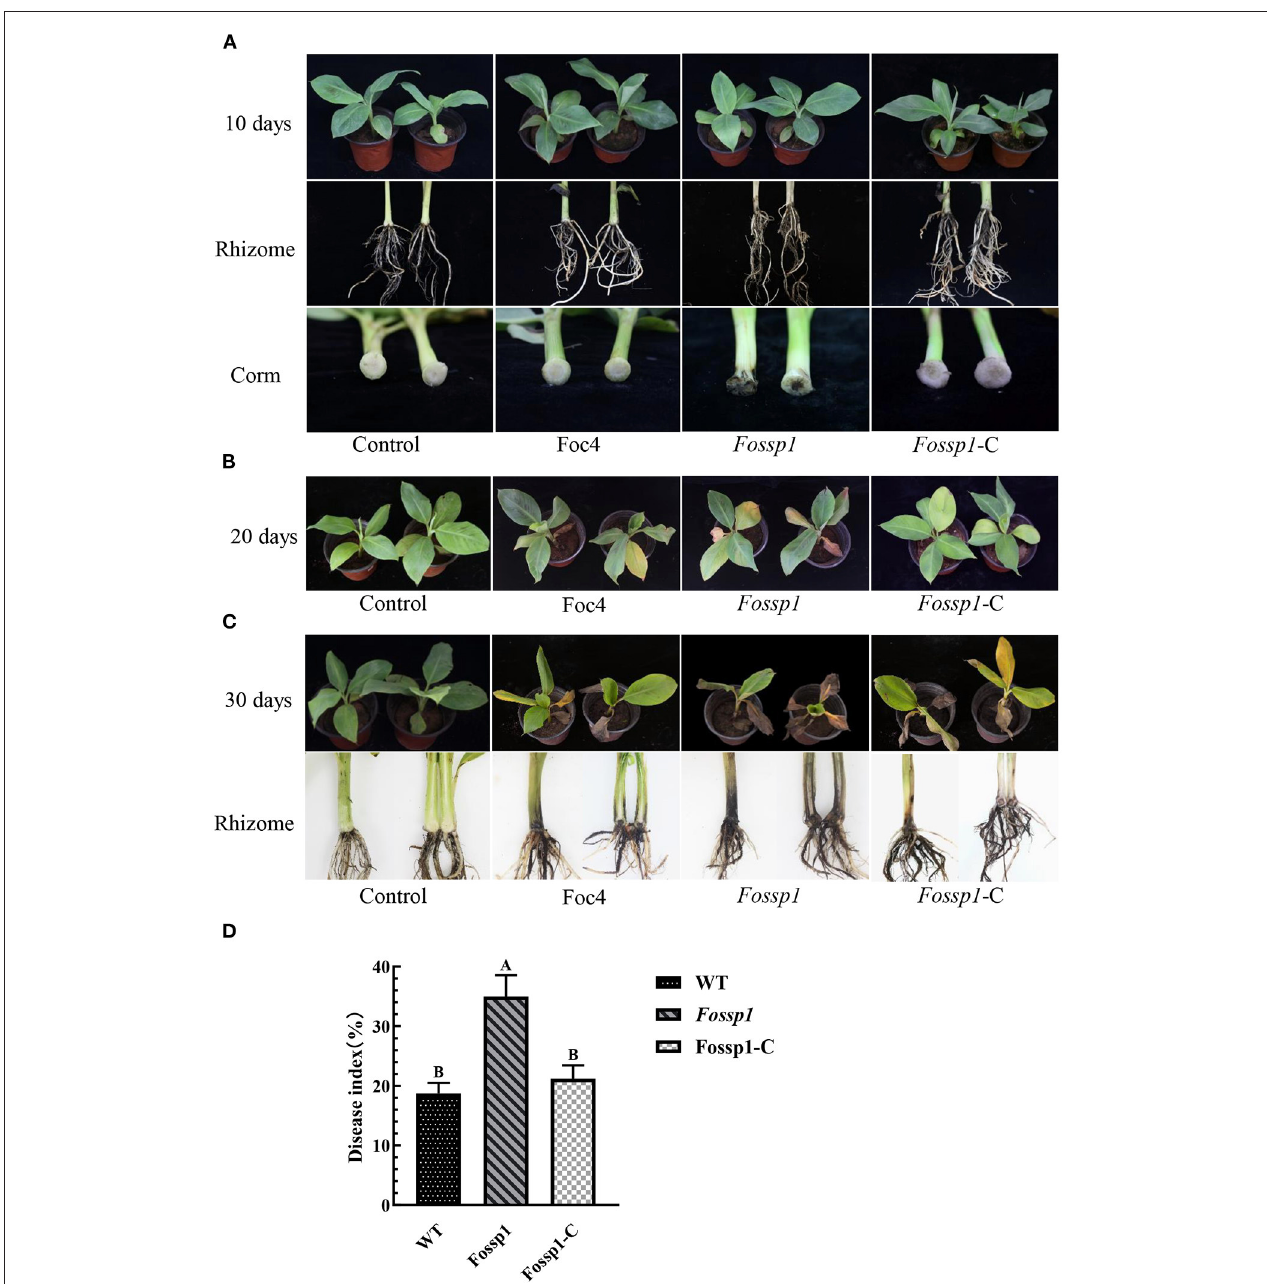
FIGURE 5 | Deletion of FoSSP1 increased the virulence of Foc4 on roots and rhizomes of bananas. Compared with the WT, the corms of banana seedlings inoculated with Fossp1 showed obvious brown spots after 10 days (A) , and leaf yellowing appeared after 20 days (B) . The pseudostem and root displayed typical discoloration of infected seedlings after 30 days (C) . The experiment was repeated 3 times with 10 replicates for each of the three strains. (D) The disease index of bananas was scored 20 days post